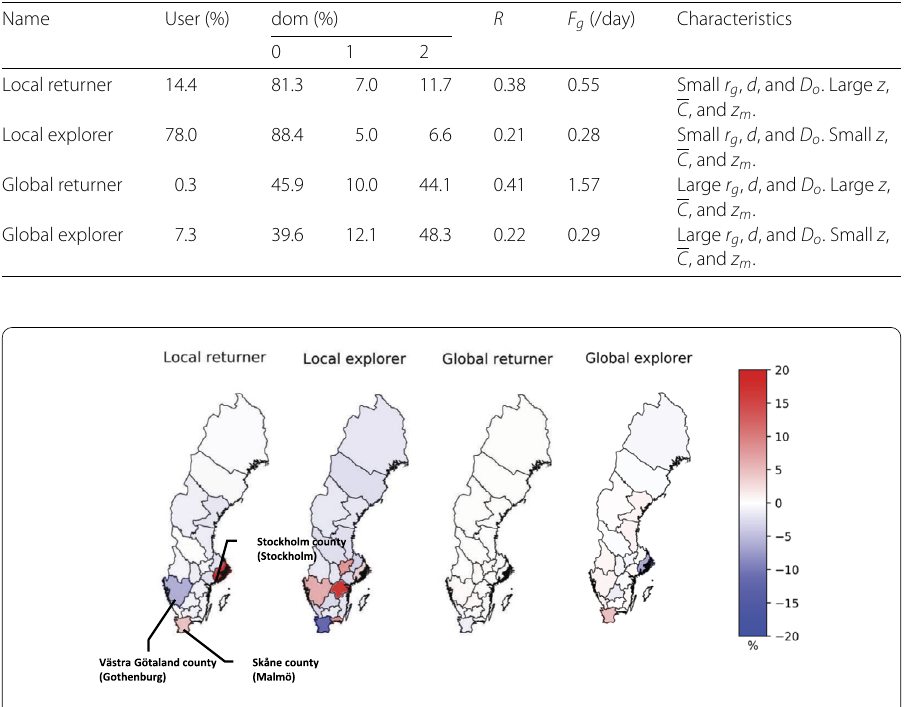
Table 3 Statistics of four behaviour groups. dom represents the percentage of trips where both the origin and destination are in Sweden (0), among the destination and the origin, there is one location outside Sweden (1), and both the origin and destination are outside of Sweden (2). R denotes the ratio of visiting frequency of the most frequently visited location over the total number of geotagged locations. F g denotes the geotweeting